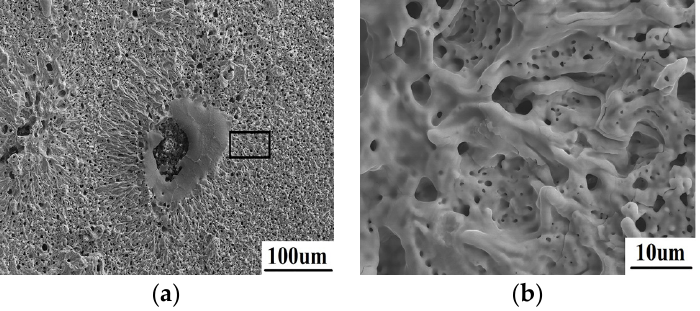
Figure 4. The microscopic morphology of area 1 ( a ) with a typical flushing morphology ( b ).